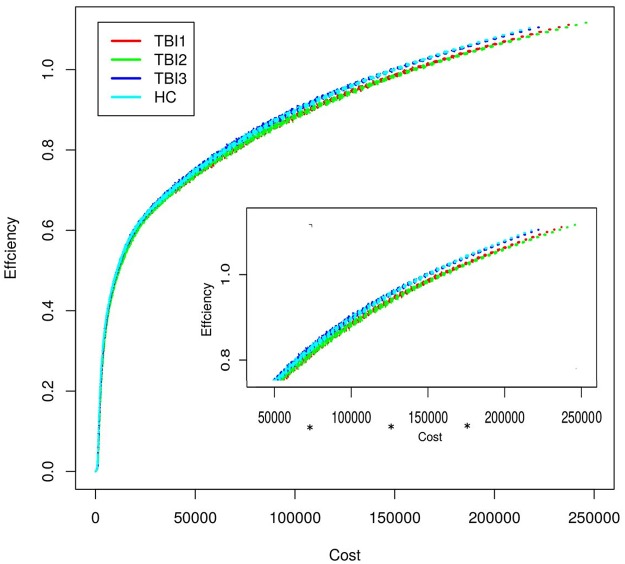
Illustrates cost-efficiency relationship of group-averaged TBI network at all 3 time points (see Section 3.1.4 for details).For cost bands 50000–100000, 100000–150000, and 150000–20000, there was a significant difference between the Time-2 and Time-3 efficiency values based on independent sample t-test. The Bonferroni corrected p-values and Cohen's-d for all cost bands are as follows, 0–50000 (p-value = 0.61, cohen's-d = 0.04), 50000–100000 (p-value << 0.05, cohen's-d = 0.30), 100000–150000 (p-value << 0.05, cohen's-d = 0.54), 150000–200000 (p-value << 0.05, cohen's-d = 0.70), and 200000–250000 (p-value = 1, cohen's-d = 0.06).